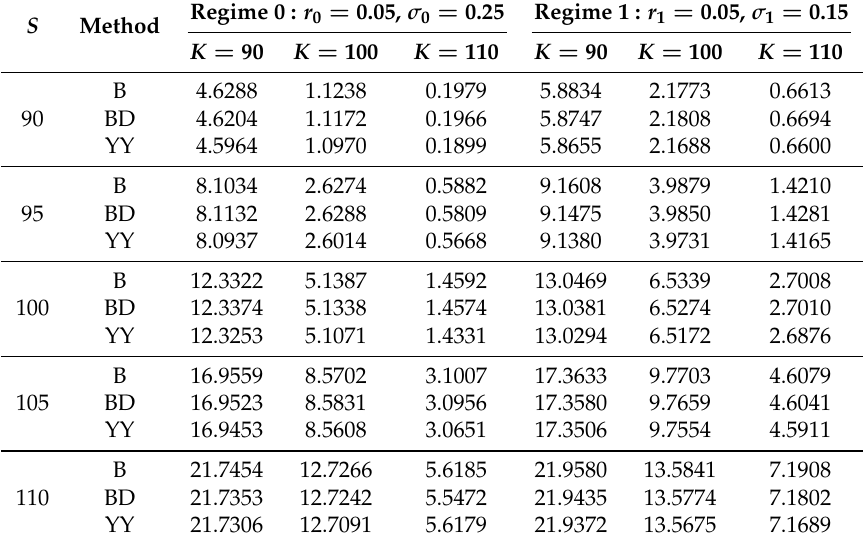
Table 1. European Asian call option prices in a two-regime economy with a 0,1 = a 1,0 = 1